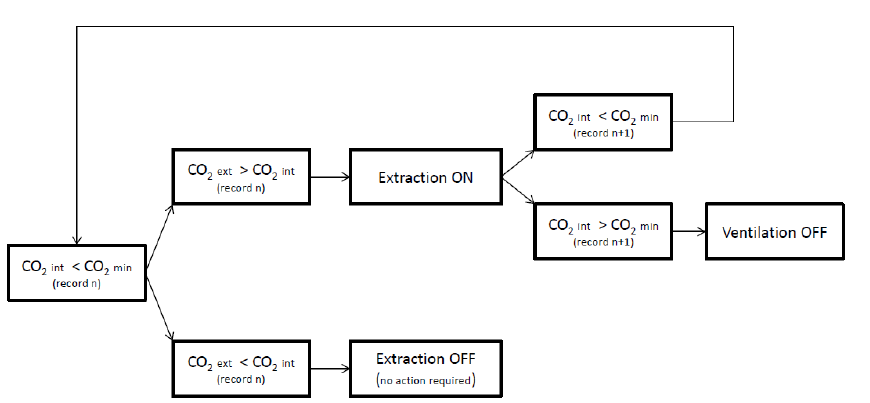
Figure 8. Control loops when CO 2 int <CO 2min .